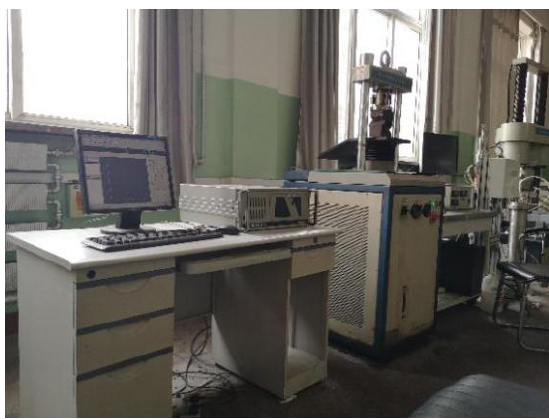
Figure 2. Mechanical properties testing of coal samples. Table 1. Elastic Modulus of coal samples.